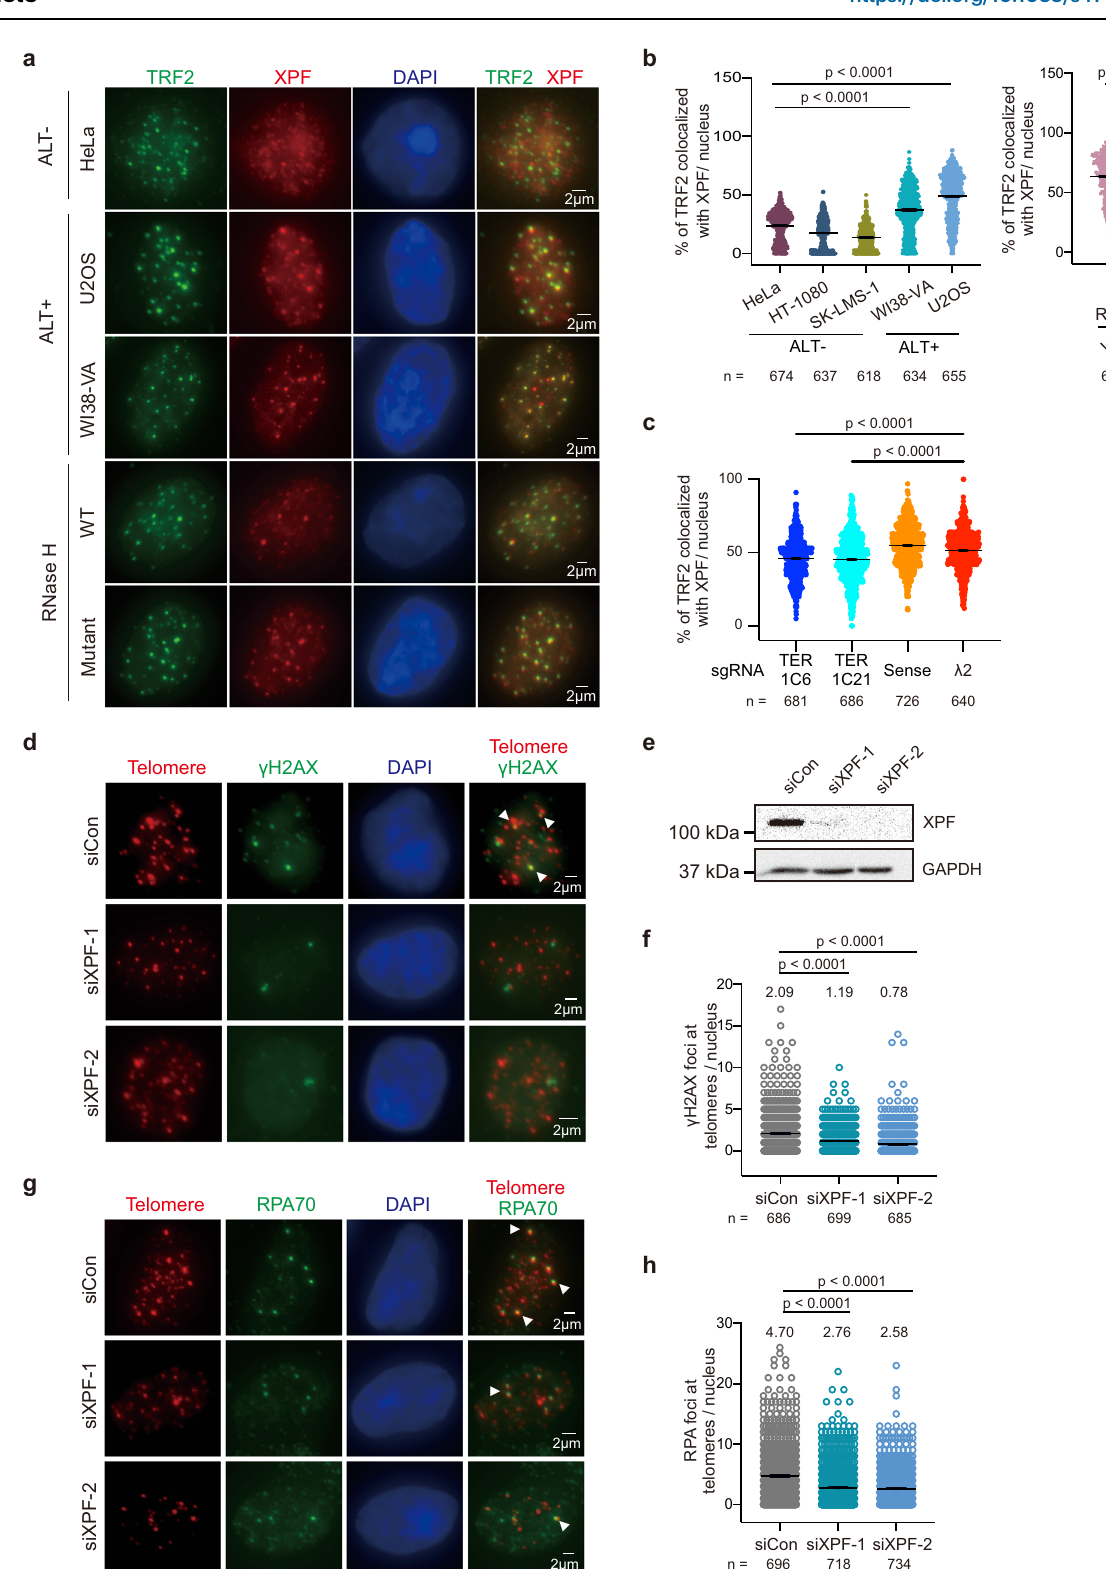
cells. The treatment of ERCC1-XPF inhibitor NSC130813 56 (Fig. 7c) exhibited a higher toxicity in U2OS cells (ALT) than in HeLa cells (non- ALT). The effect of NSC130813 on XPF and ERCC1 was determined by immunostaining (Supplementary Fig. 8f) that showed a decrease of XPF-ERCC1 colocalization events. The protein levels of XPF and ERCC1 were also reduced (Supplementary Fig. 8g) in U2OS cells treated